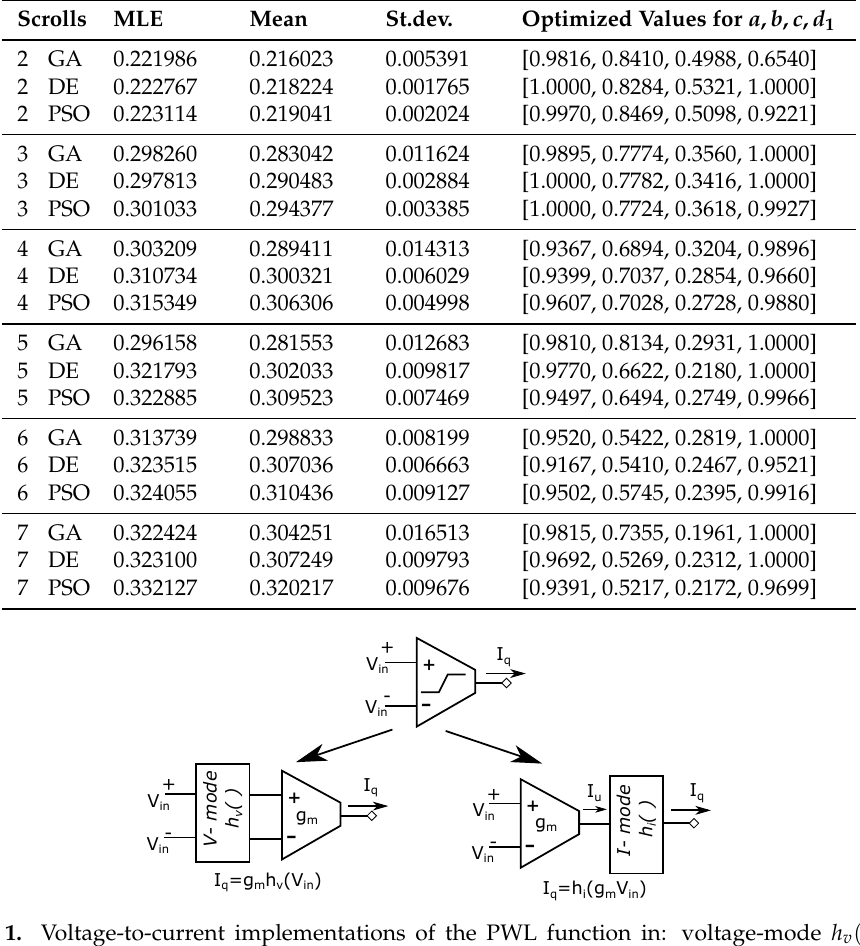
Figure 1. Voltage-to-current implementations of the PWL function in: voltage-mode h v () ; and current-mode h i () .